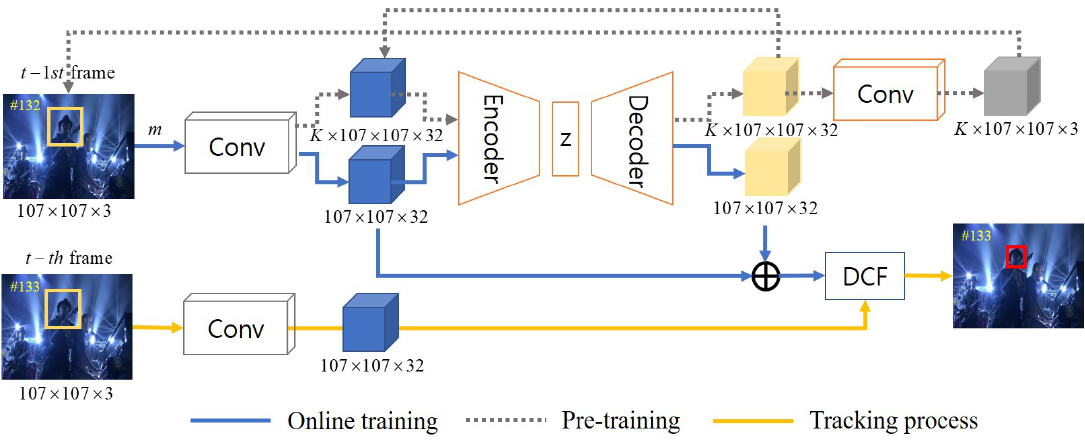
Figure 2. The overall network architecture and tracking process of the proposed tracking